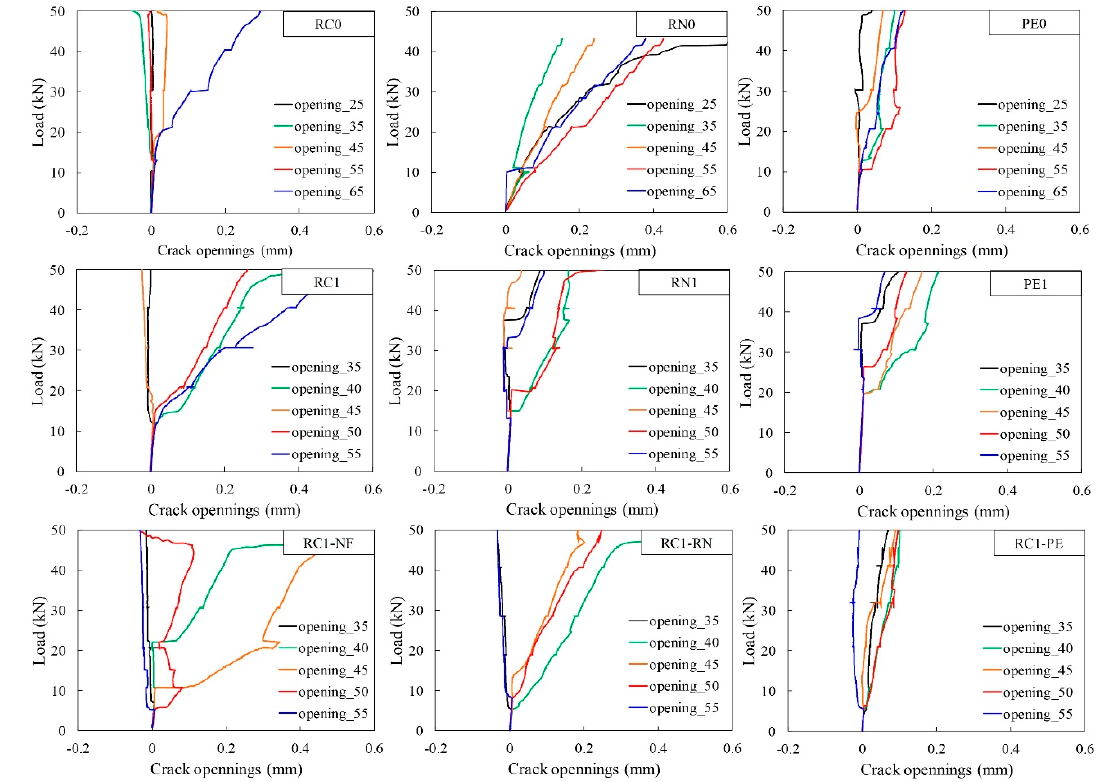
Figure 9. Crack openings at the bottom surface of the tested beams.